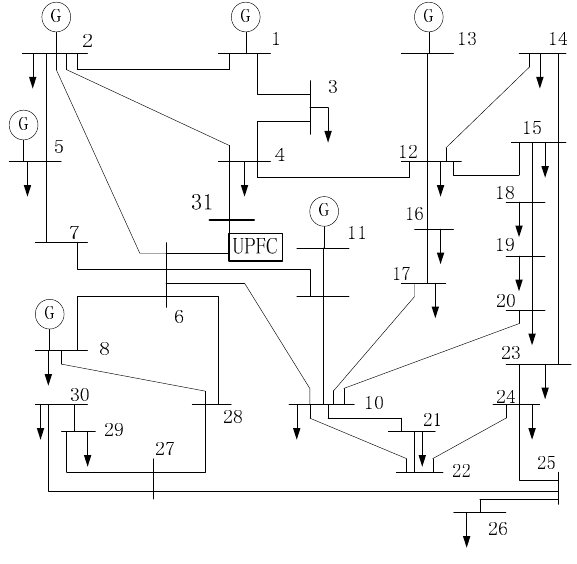
Figure 4. Diagram of IEEE 30-bus system.